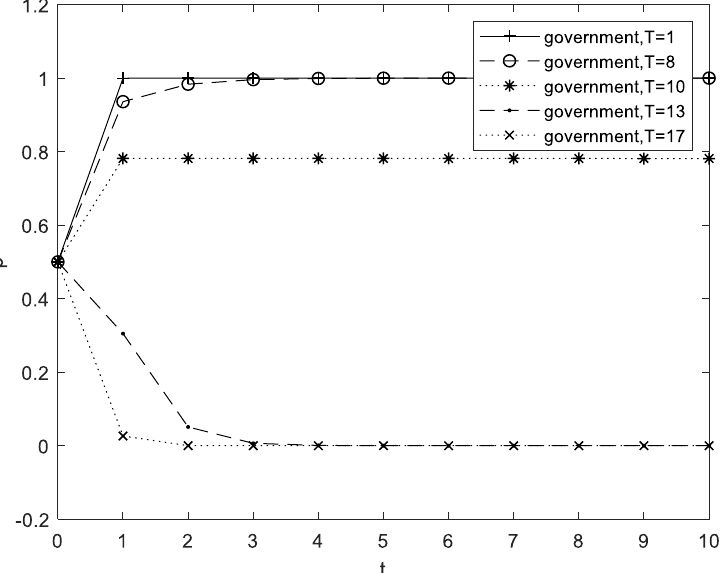
Figure 8. After a public health emergency, government regulatory agencies give more tax incentives